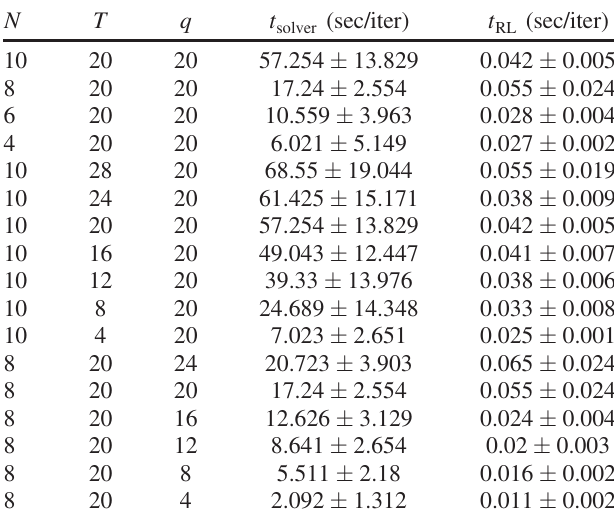
TABLE IV. Wall-clock running time of the two-level CD- QAOA optimization steps with different system sizes N , protocol durations T , and circuit depths q . The right-hand side of the table shows the time used for the lower-level solver (column t ) and solver the time spent for the high-level RL algorithm (column t ) at RL every successful iteration. The total cost can then be obtained by multiplying the time for t by the appropriate number of solver repetitions (e.g., continuous solver realizations, policy sample batch size, PPO training episodes, etc.), taking into account any parallelization if present. Every number represents an average over 40 independent runs with the corresponding standard deviation shown; the significant deviation in t is caused solver by the random initial solver state used, which causes the algorithm to take a different number of steps to converge within the given tolerance (cf. Appendix D). This test is carried out on